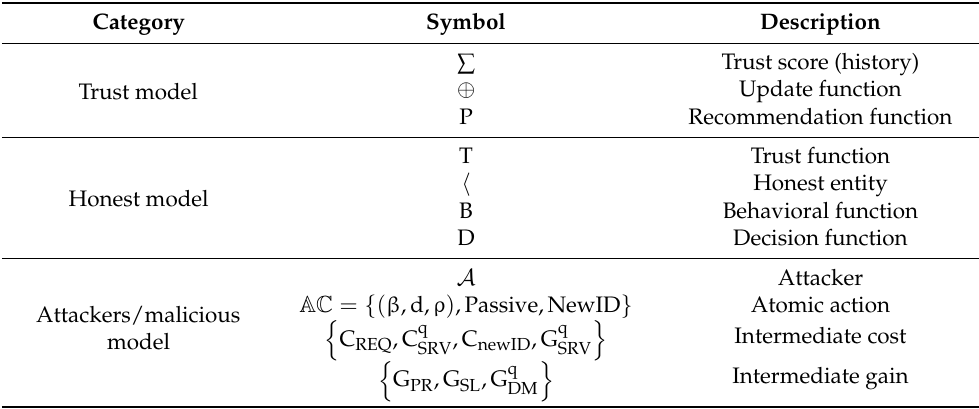
Table 3 defines a formal representation of trust-based SOA-IoT by using HOL symbols and interaction ways between IoT entities. Table 3. The variables of trust and reputation